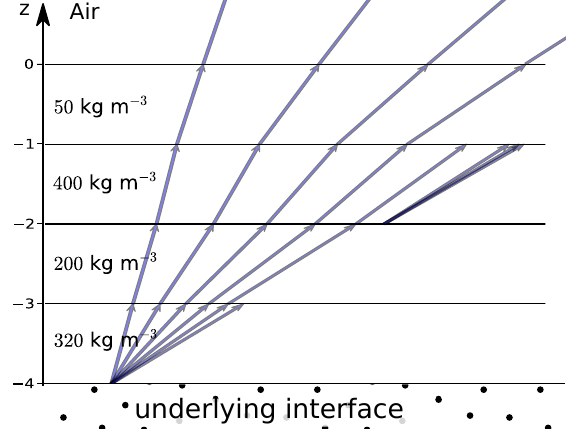
Fig. 2. Upwelling streams for a 4-layer snowpack with varying density. The stream directions are calculated with Snell’s refraction law using the real part of the effective propagation constant E eff (Eq. 6) that mostly depends on snow density. The number of streams is 8 in the most dense layer and decreases as the density decreases. Only 4 streams emerge in the air above the snowpack. For clarity, downwelling streams are not